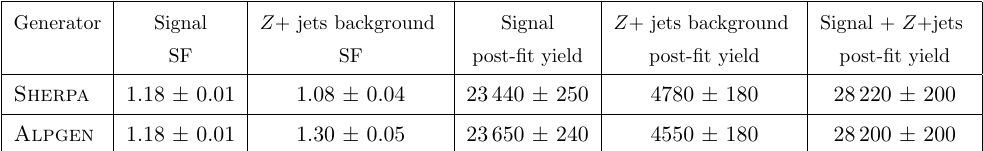
Table 5 . Scale factors obtained for the (cid:12)tted signal and Z +jet background for Sherpa and Alpgen (cid:12)ts, the total post-(cid:12)t yields, and the statistical uncertainty, estimated with pseudo-experiments, from the (cid:12)t for the 2-tag signal